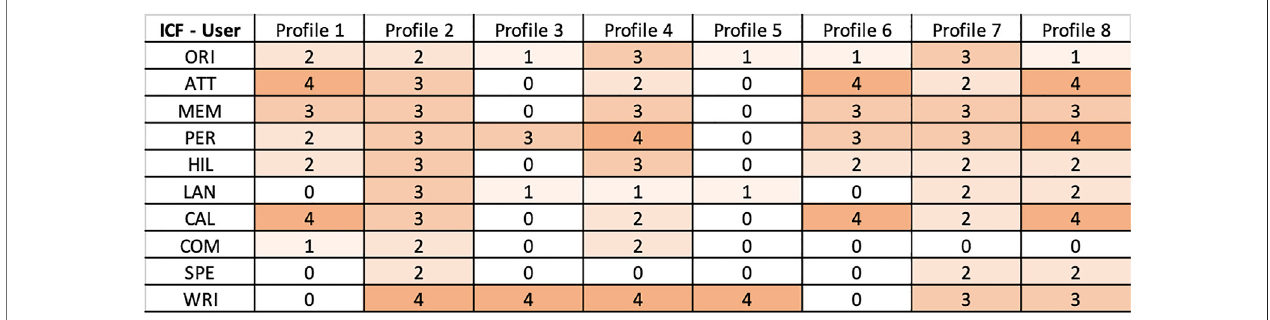
FIGURE 4 | Final ICF scoring of users.